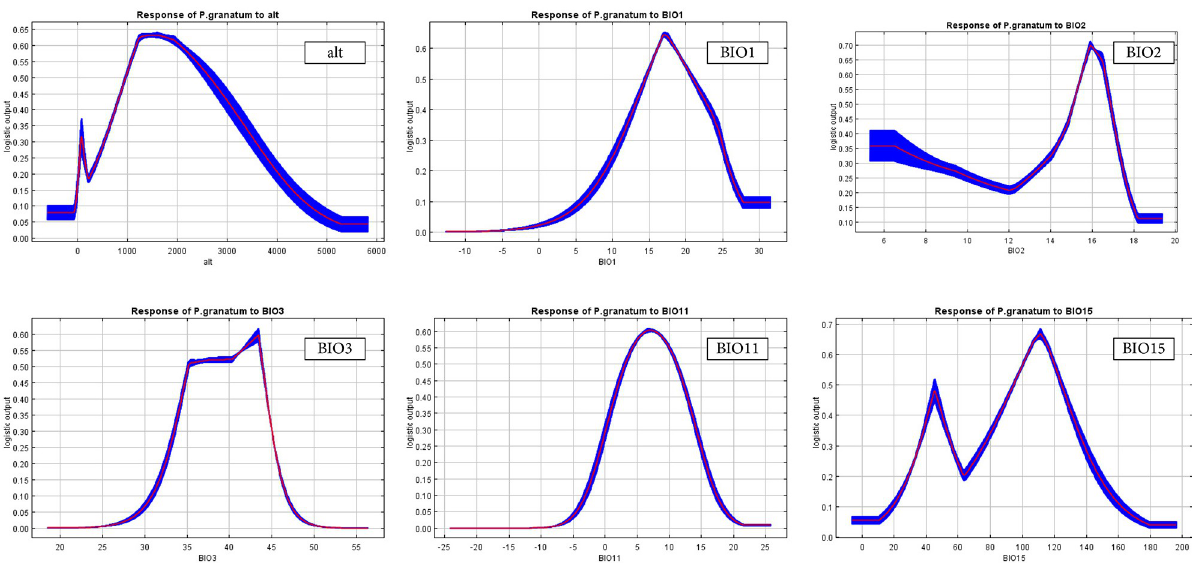
Fig 12. Response curves for important environmental variables in the species distribution model for pomegranate. Red curves shows the mean response of the 10 replicates, and blue shade is the mean +/- one standard